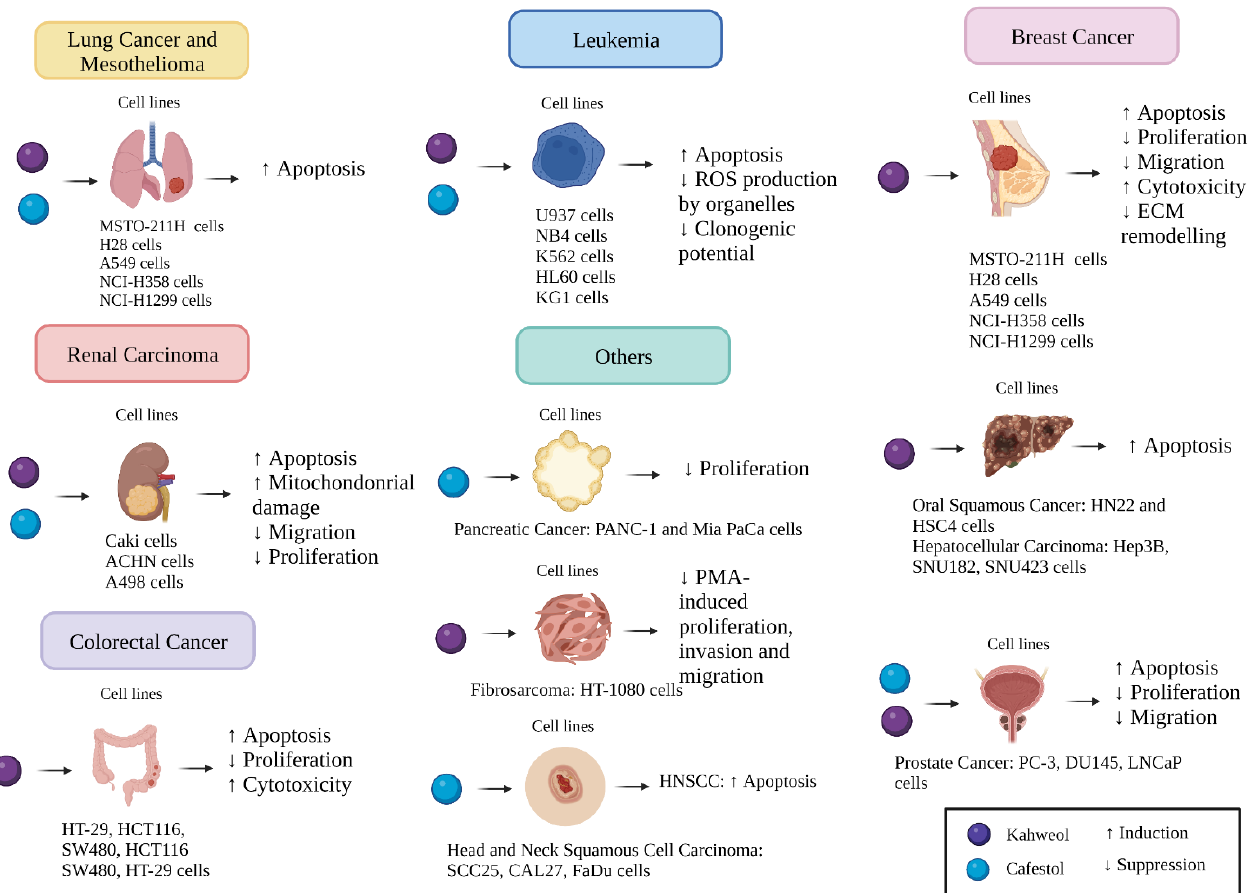
Figure 2. A diagram summarising the potential anti-cancer mechanisms of kahweol and cafestol in different cancer cell lines. Created by BioRender.com.